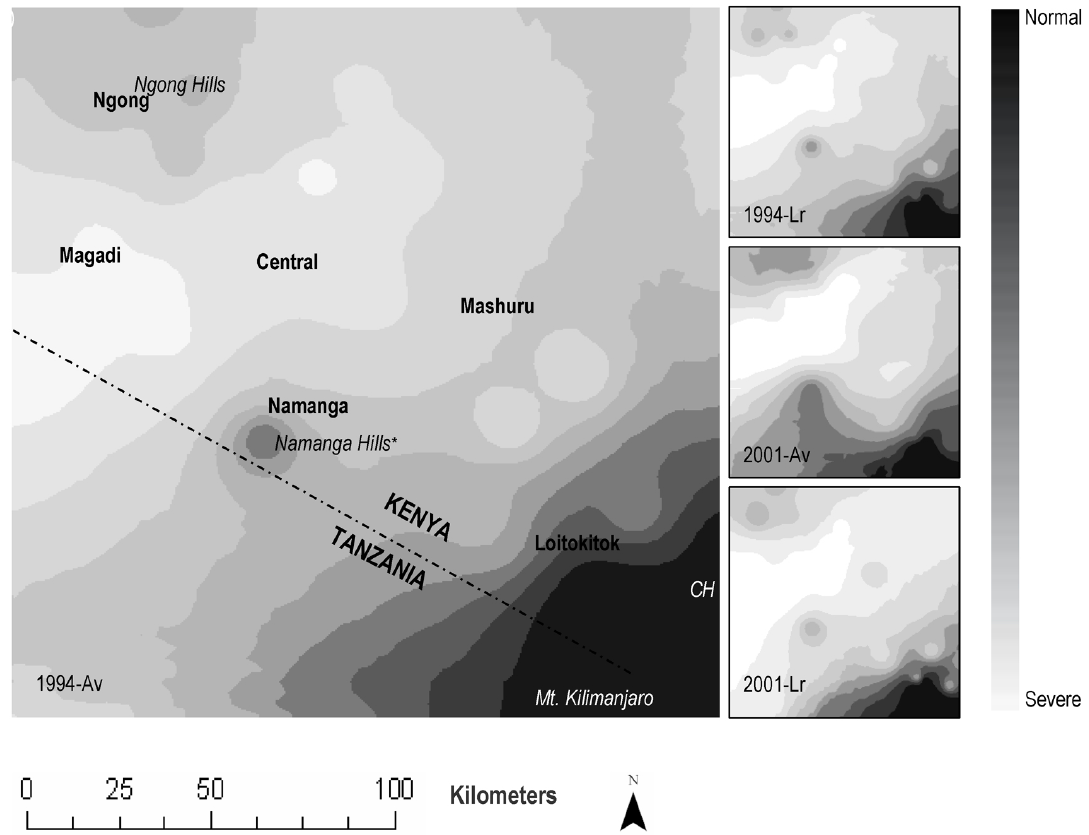
Figure 3. Drought intensity across spatial scales based on standardized drought index using rainfall station data. Namanga Hills are the Ol Doinyo Orok and Lemilebru-Ingito Hills. CH = Chyulu Hills. The progression of color from dark hue (high values, ca. ( ´ 0.5)–(0.0) e.g., 0 around Mount Kilimanjaro) to light shade (low values, ca. ( ´ 0.6)–( ´ 5.0)), e.g., ´ 5.0 around Magadi) symbolize intensity of